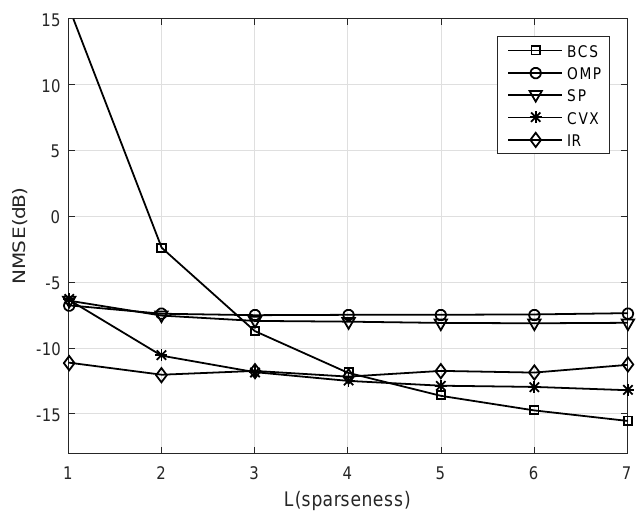
Figure 3. NMSE of the estimated CSI versus sparseness with received SNR = 10 dB, pilot symbol frames M = 16, angle quantization G = 32 and without hardware impairment.